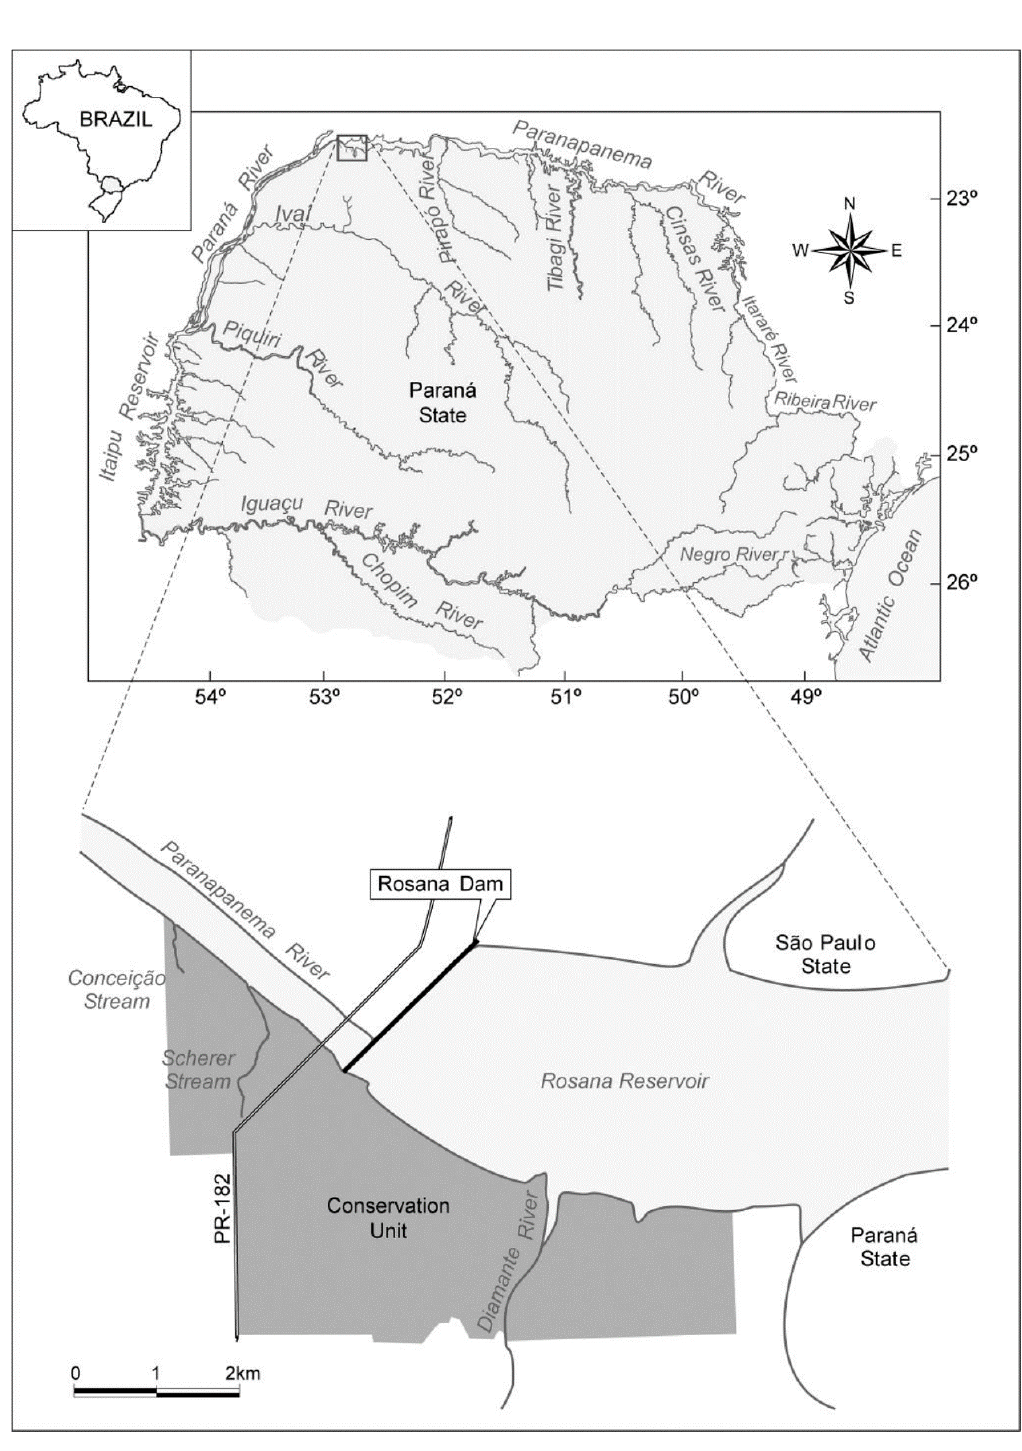
Figure 1. Sampling stations in Caiuá Ecological Station riparian areas along Conceição and Scherer streams, Northwest Paraná